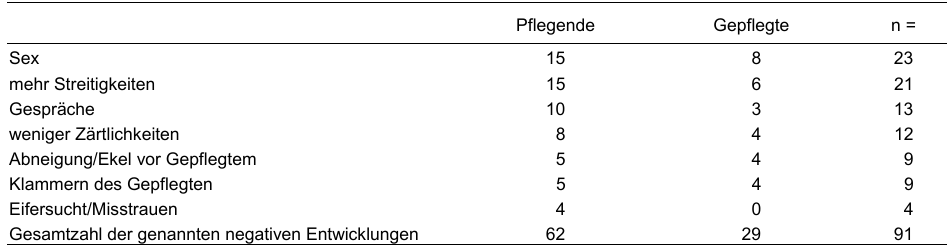
Tabelle 3 : Negative Veränderungen der Partnerschaft im Rahmen der Pflege (mehrere Antworten waren möglich)